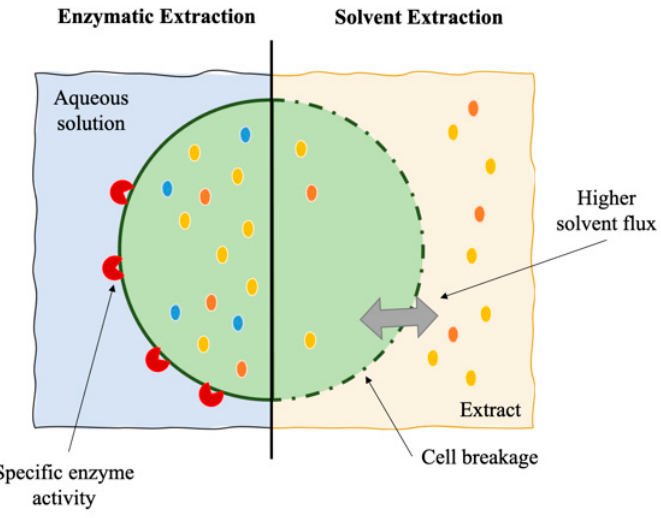
Figure 2. Schematic representation of an enzymatic extraction followed by a solvent extraction.